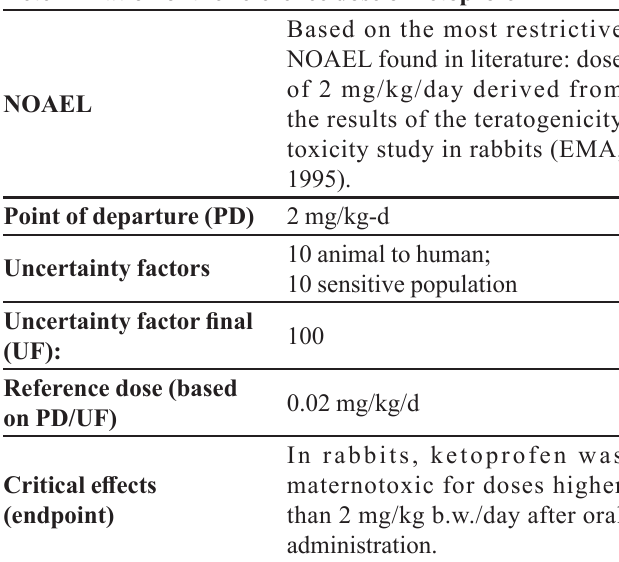
higher than 2.8 mg L -1 and 0.14 mg L -1 for ibuprofen